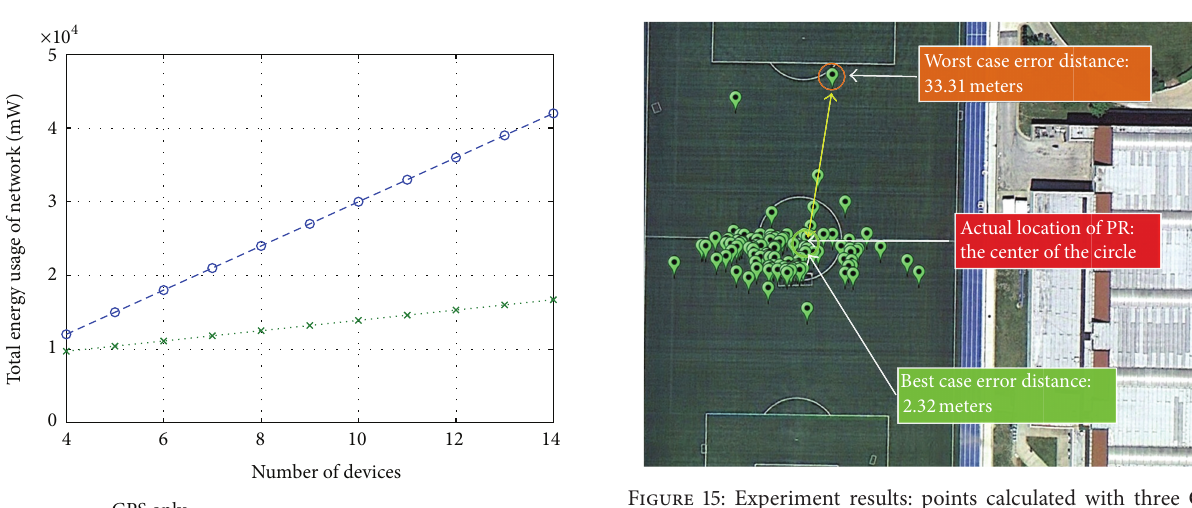
Figure 15: Experiment results: points calculated with three GPS coordinates and RSSI values.